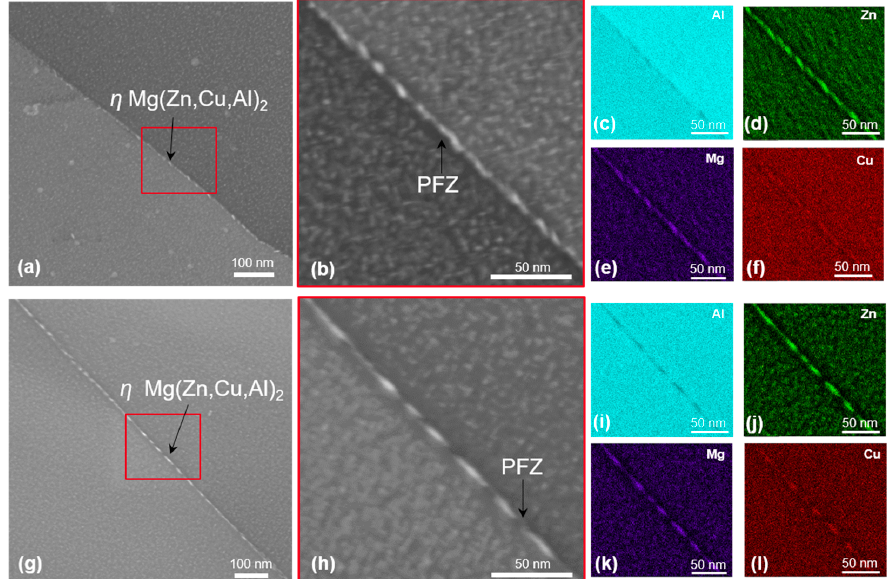
Figure 9. STEM dark-field images and EDX maps of alloys in T6 state: ( a – f ) 7449 and ( g – l ) 7449+Cr. The red boxes indicate the region of interest for EDX mapping.